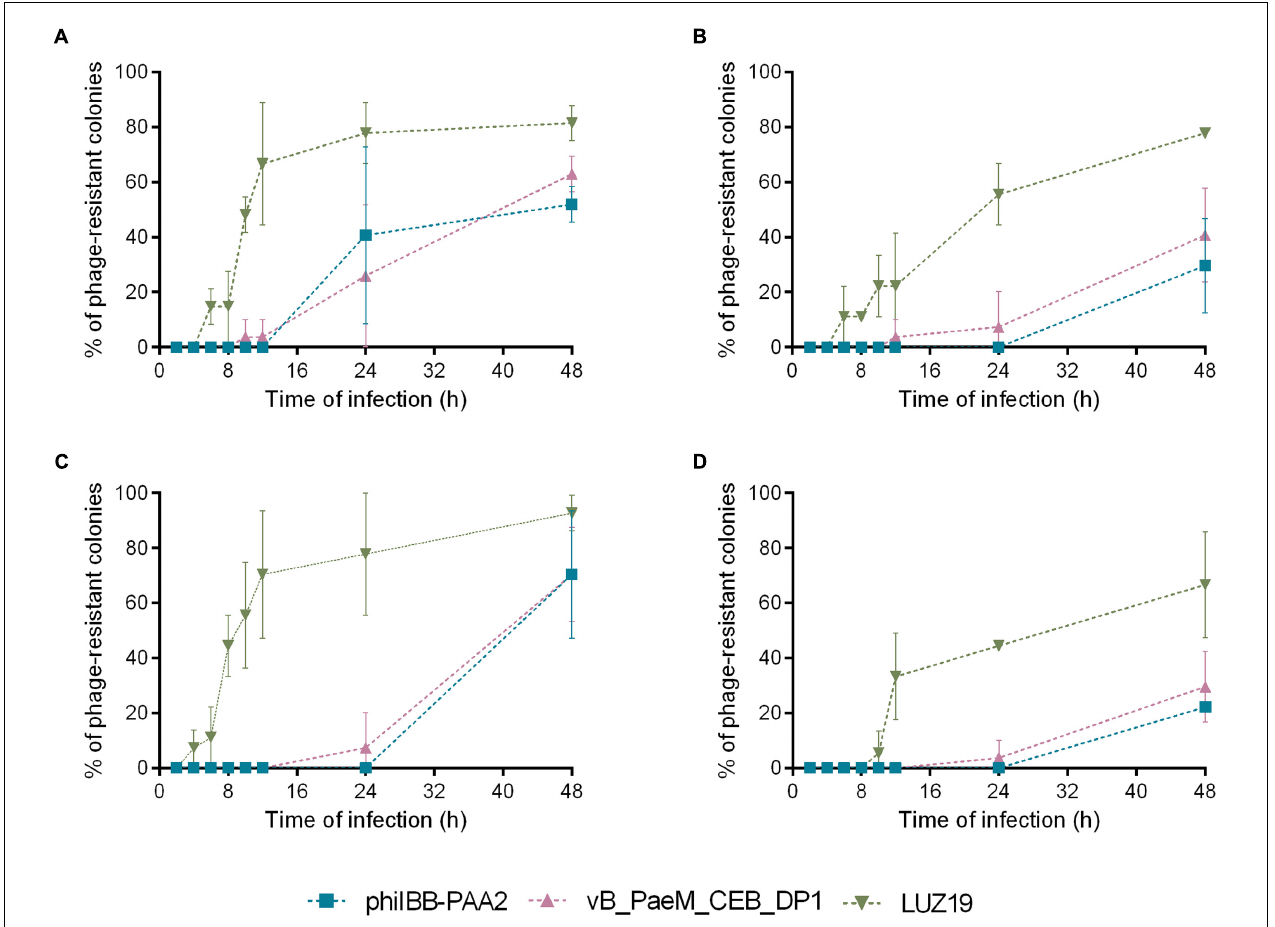
FIGURE 2 | Percentage of P. aeruginosa PAO1 colonies isolated in each time point of infection experiments that were resistant to phages phiIBB-PAA2, vB_PaeM_CEB_DP1 and LUZ19. (A) Percentage of phage-resistant colonies isolated from biofilm infection experiments with each phage individually. (B) Percentage of phage-resistant colonies isolated from biofilm infection experiments with phage cocktail. (C) Percentage of phage-resistant colonies isolated from planktonic cultures infection experiments with each phage individually. (D) Percentage of phage-resistant colonies isolated from planktonic cultures infection experiments with phage cocktail. Error bars represent standard deviations from three independent